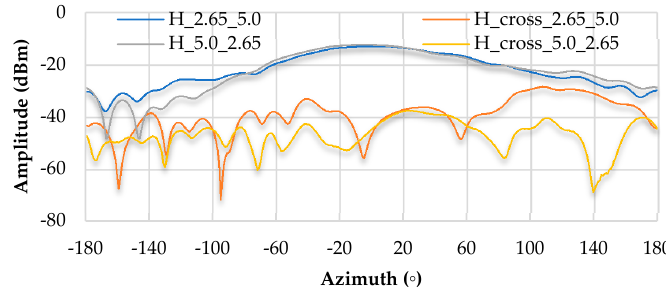
Figure 22. Comparison of the radiation diagram to ± 5° in the H plane.